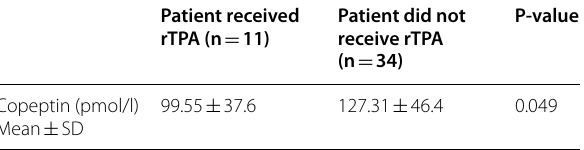
Table 6 Copeptin level in stroke patients who received rTPA and patients who did not receive rTPA